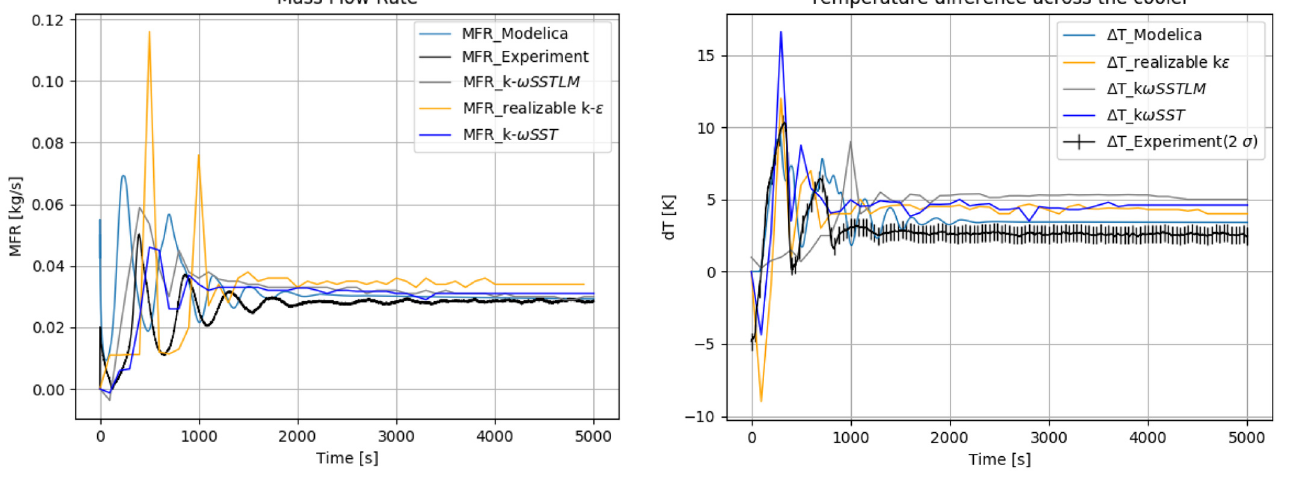
Fig. 8. Mass flow rate.